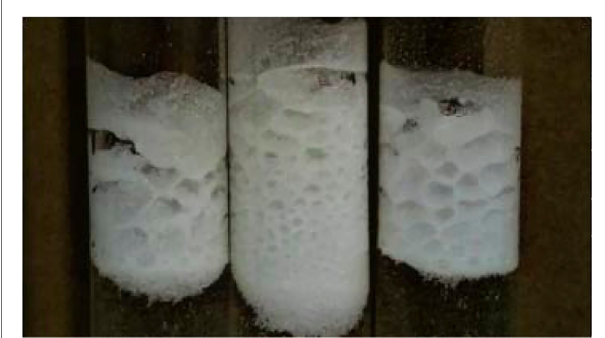
FIGURE 7 | Foam structure with different particle combinations (From left toright: 1.0 wt%PTFE,2.0 wt%PTFE,1.0 wt%PTFE, and 1.0 wt%PVC; PTFE, 20 μ m, PVC, 270 μ m).